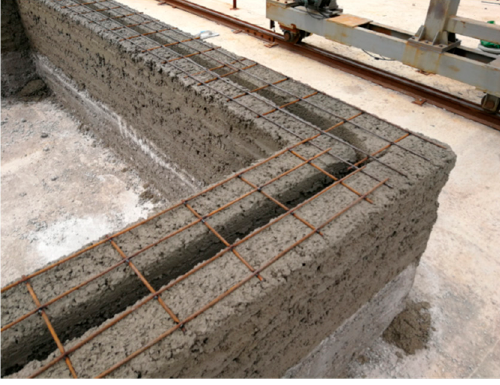
Figure 10. Horizontal steel mesh.